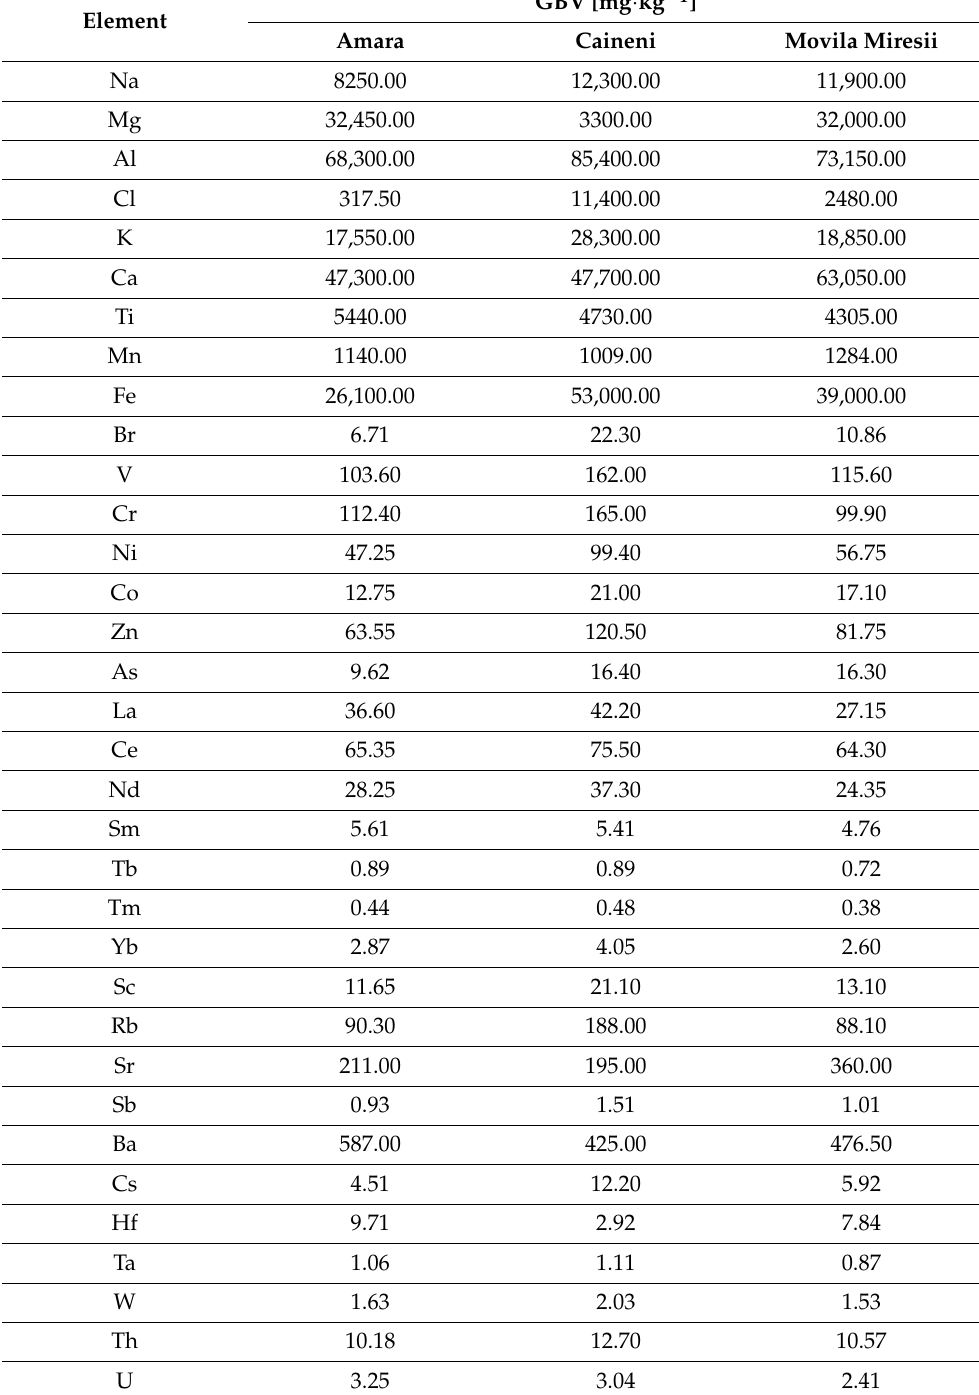
Table 5. The geochemical background value (GBV) calculated by M2MAD